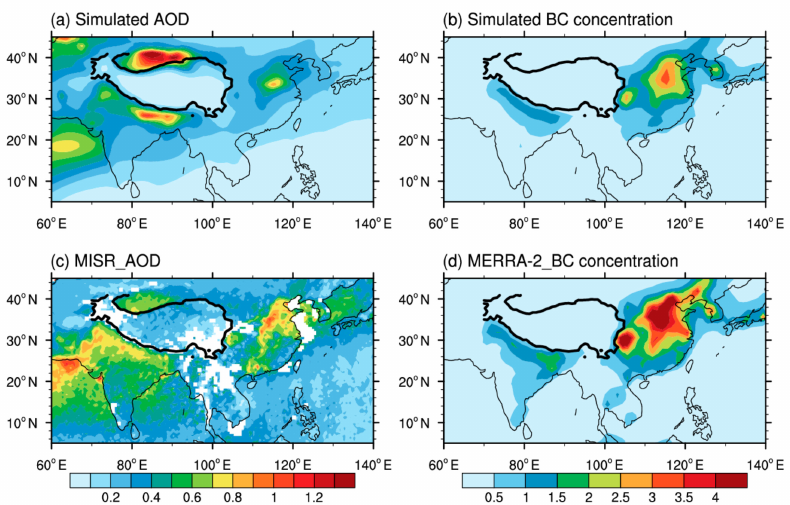
Figure 4. Distributions of aerosol optical depth (AOD) and black carbon (BC) mass concentration ( µ g / m 3 ) in the summer for a period from 2001 to 2005, ( a , b ) simulated by the CESM model. ( c , d ) are derived from the data of Multi-angle Imaging Spectro Radiometer (MISR) satellite observations and MERRA-2 reanalysis data sets. The area of the TP is enclosed by a black